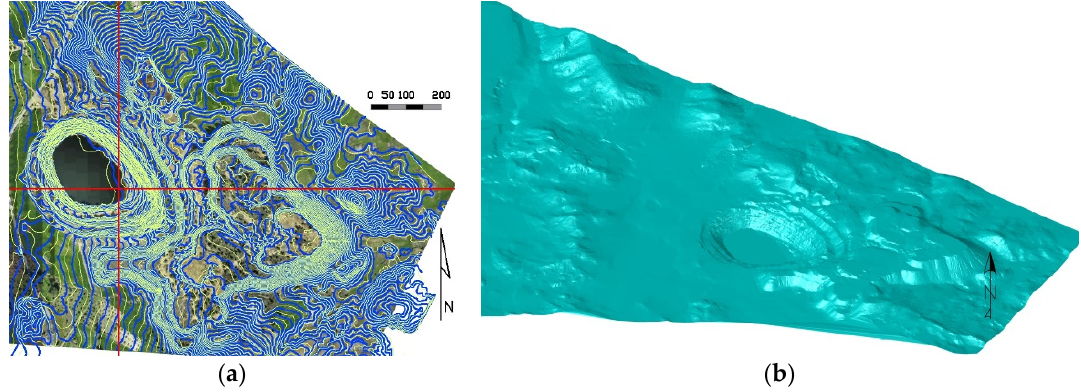
Figure 5. Mathiatis mine area isolines with ( a ) aerial photo and ( b ) the relative DTM.